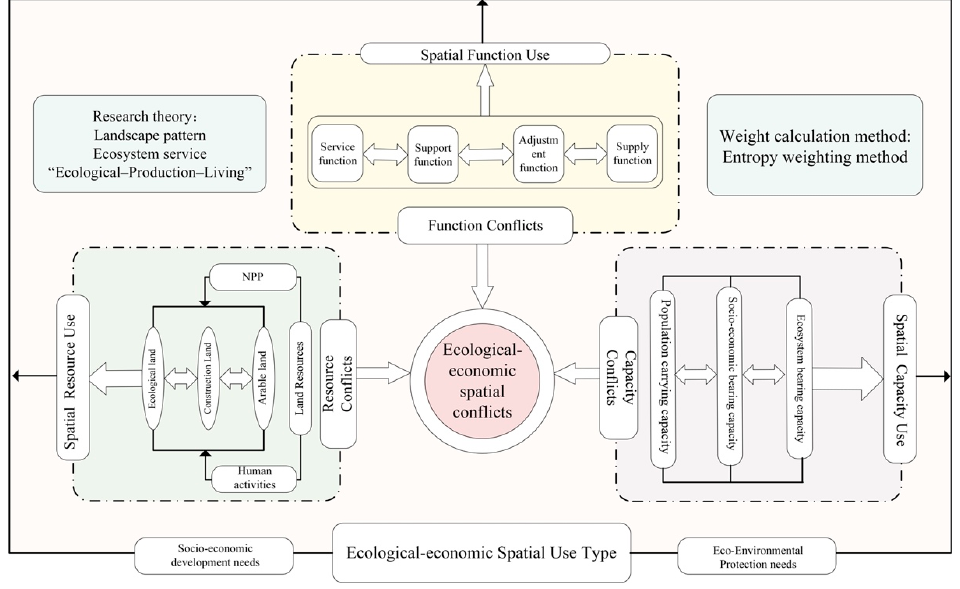
Figure 4. Indicator system diagram. Table 2. Ecological-economic spatial conflict evaluation Indicator system.